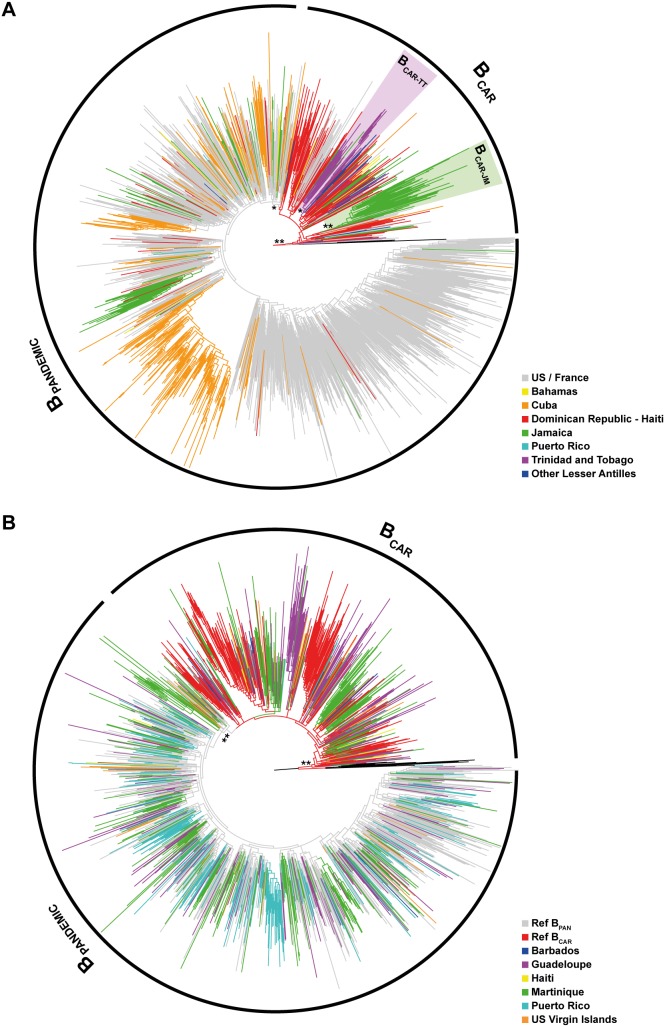
ML phylogenetic tree.A) HIV-1 subtype B pol PR/RT sequences (∼1,000 nt) circulating in the Caribbean (n = 743), US (n = 525), and France (n = 340); B) HIV-1 subtype B pol RT (∼600 nt) sequences from Barbados (n = 14), Guadeloupe (n = 243), Haiti (n = 15), Martinique (n = 452), Puerto Rico (n = 285), US Virgin Islands (n = 54) and representative sequences of the BPANDEMIC (US = 165, France = 135) and the BCAR (Caribbean = 200) clades. Branches are colored according to the geographic origin of each sequence as indicated at the legend (bottom right). Arcs indicate the BPANDEMIC and BCAR clades. Purple and green shaded boxes highlight the position of the Caribbean clades BCAR-TT and BCAR-JM. The aLRT support values are indicated at key nodes: *(0.81–0.90), **(0.91–1). Trees were rooted using HIV-1 subtype D reference sequences. The branch lengths are drawn to scale with the bar at the bottom indicating nucleotide substitutions per site.